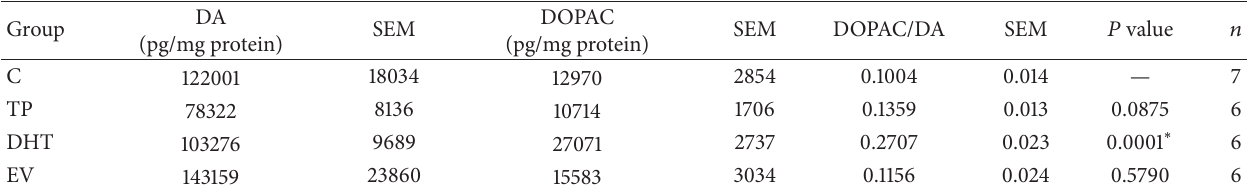
Table 2: Striatal DA and DOPAC levels from control, TP, DHT, and EV adult male rats.